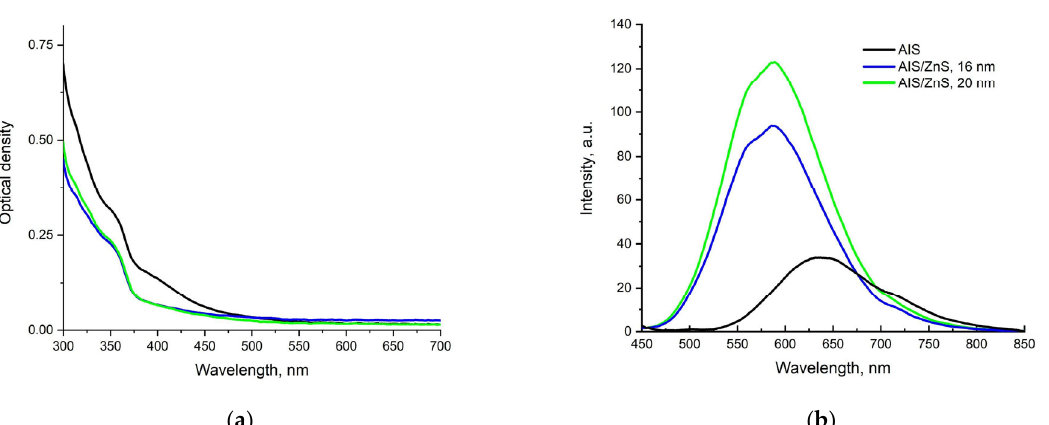
Figure 2. ( a ) The absorption spectra of QDs in an aqueous solution, ( b ) The fluorescence spectra of